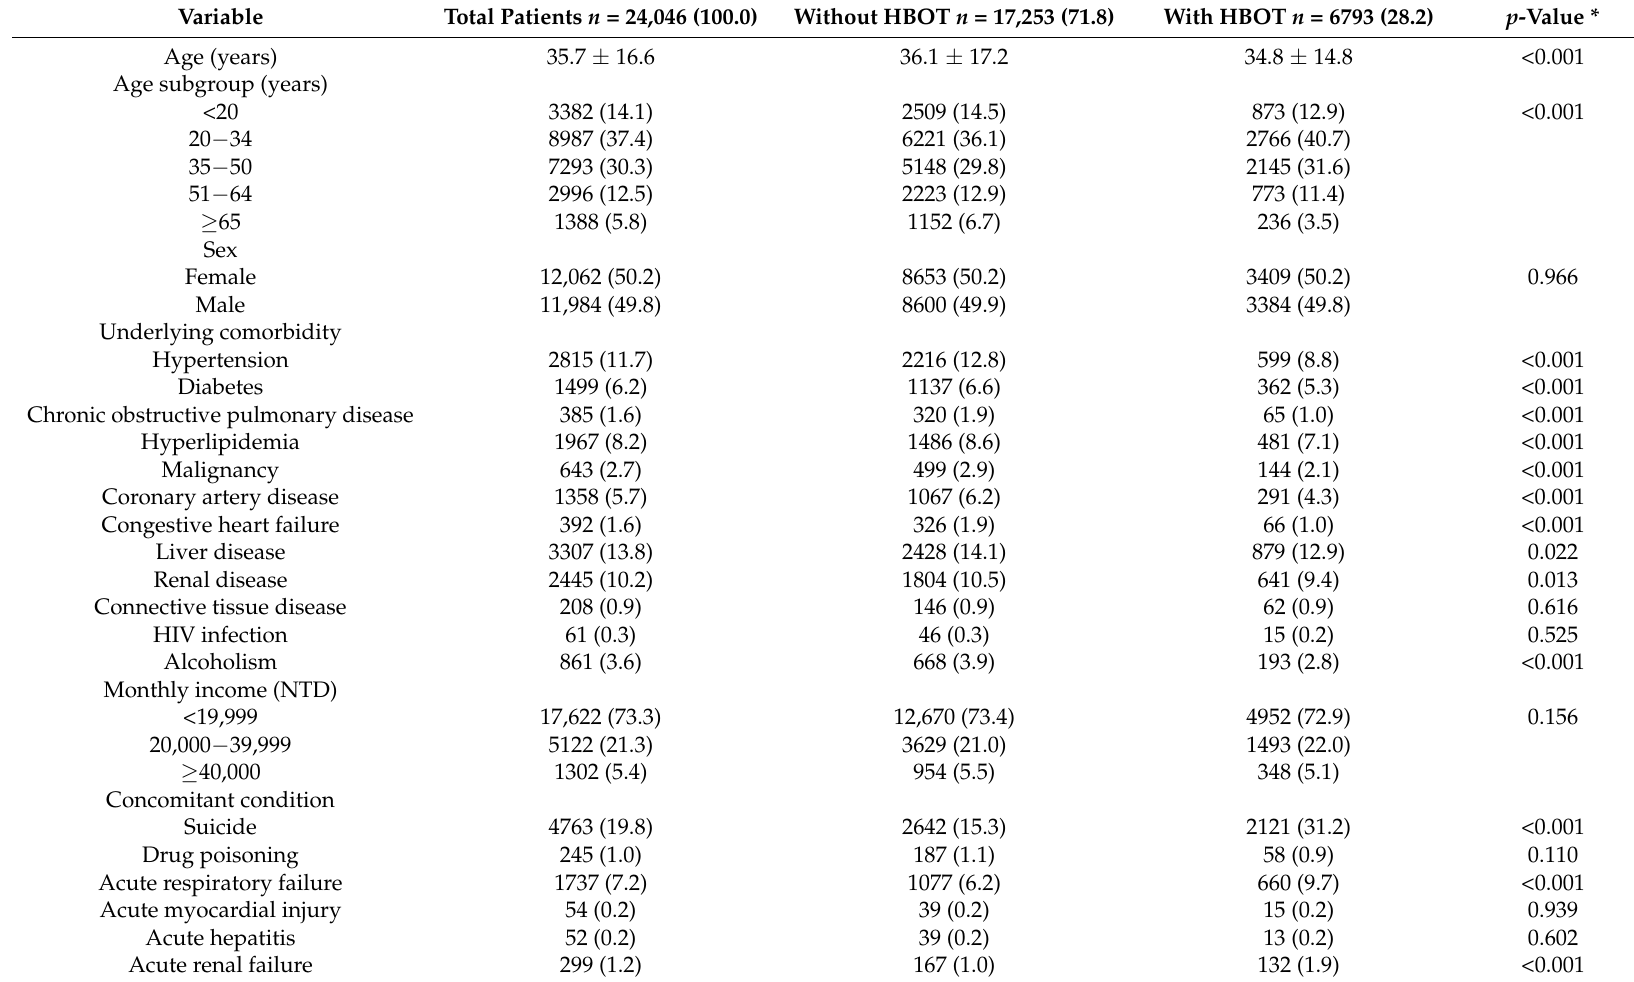
Table 1. Demographic characteristics, underlying comorbidities, monthly income, and concomitant conditions in the patients with COP between 1999 and